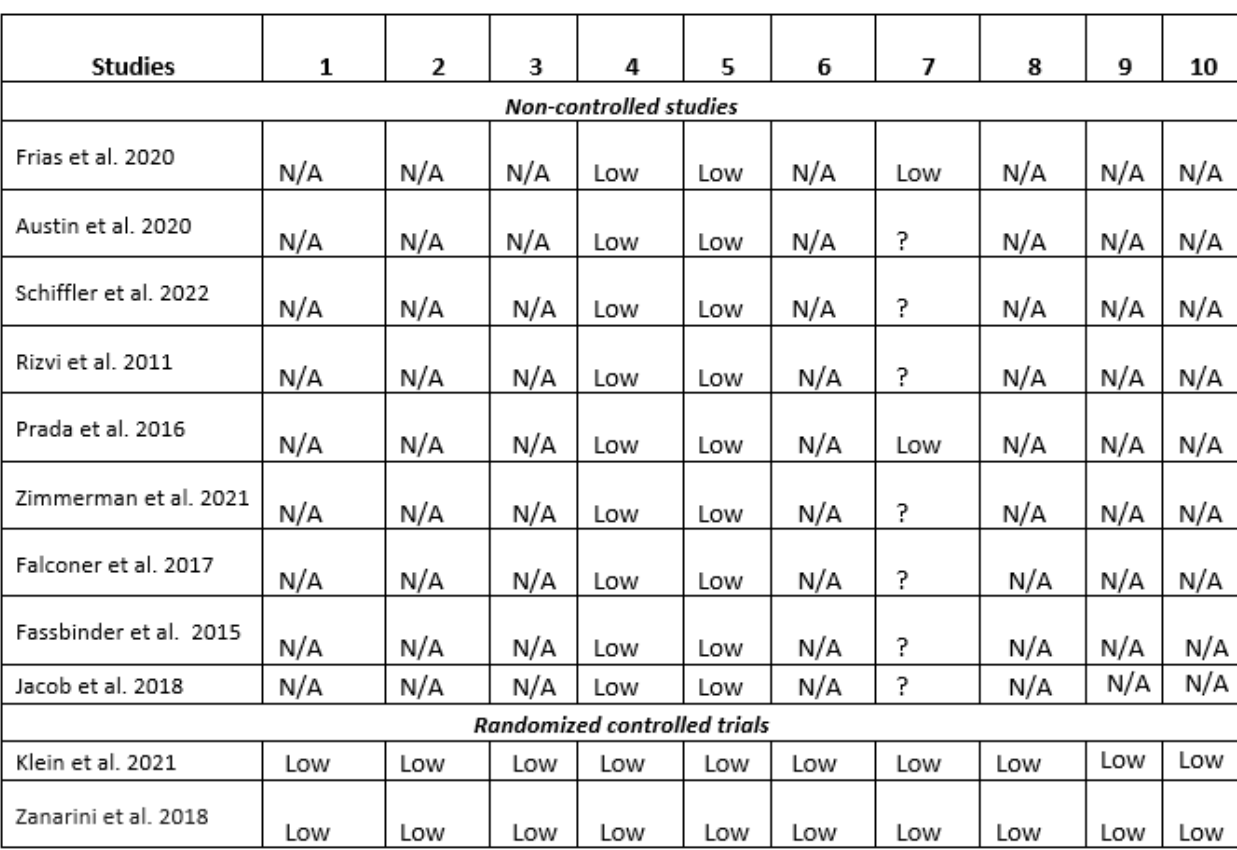
Figure 2. Methodological analysis of the identified studies [26–36].